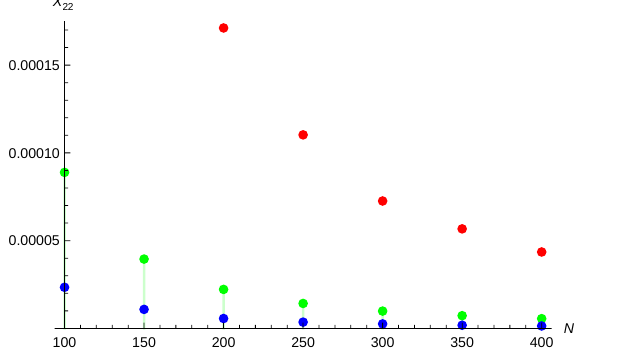
Figure 6 . Plot for k = 3. Red dots show X av [0 ; 0 : 0001750] plotted against N . Green dots represent X KZ